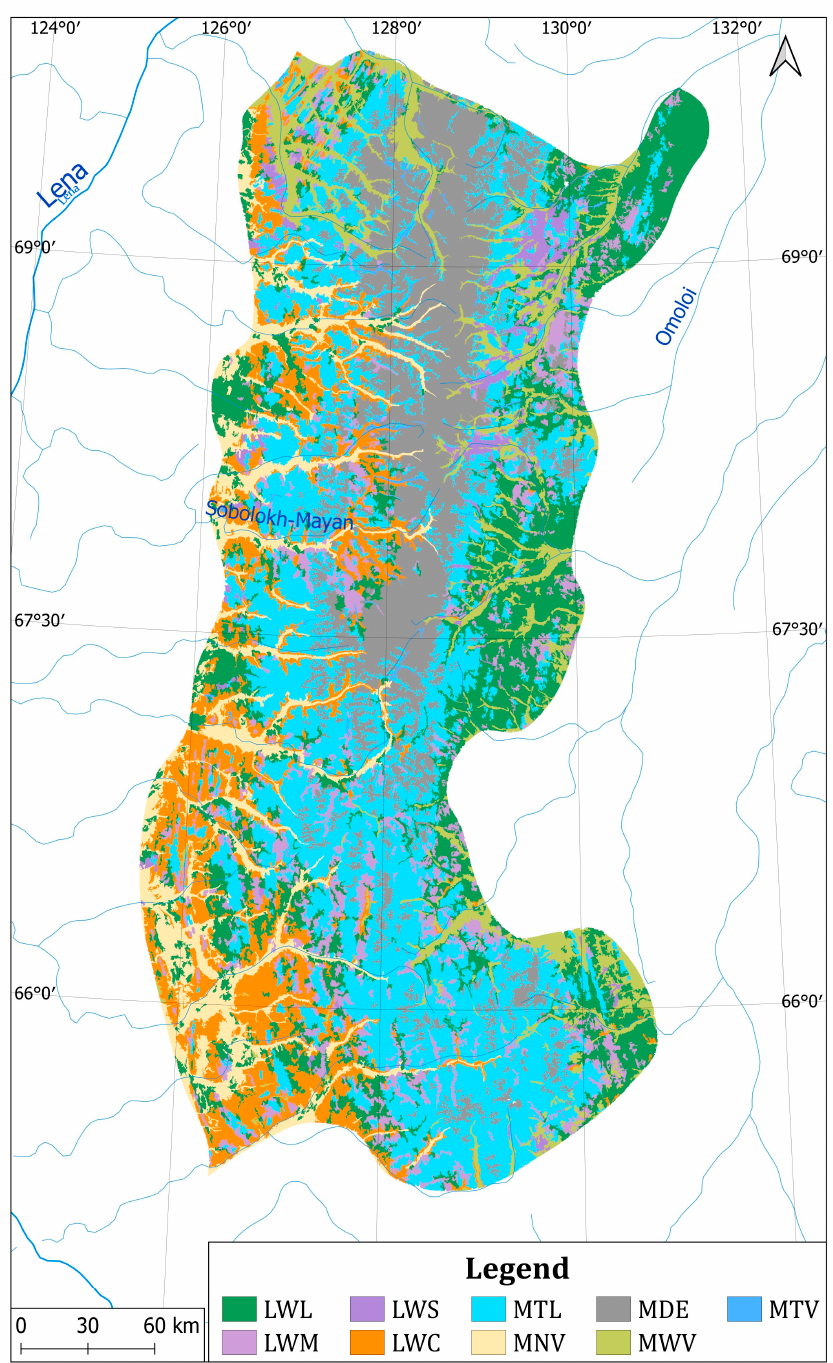
6 Figure 6. Permafrost landscape map of the Orulgan